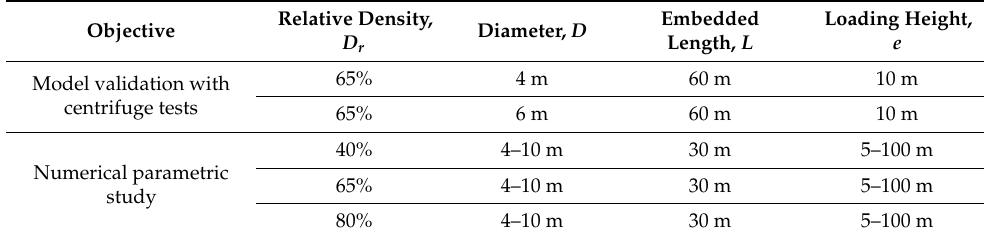
Table 2. Numerical simulation program.